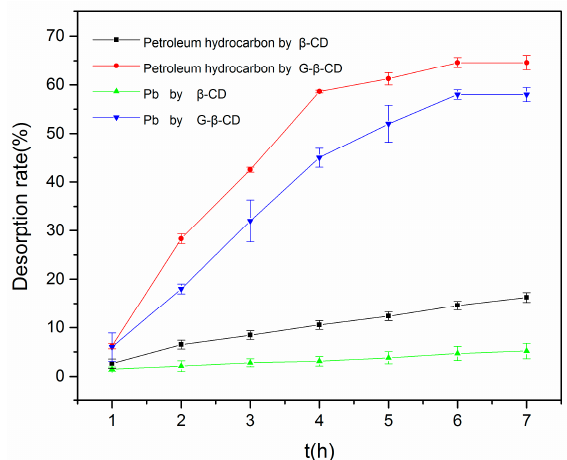
Figure 3. Desorption rate of petroleum hydrocarbons and lead with β -CD and G- β -CD.